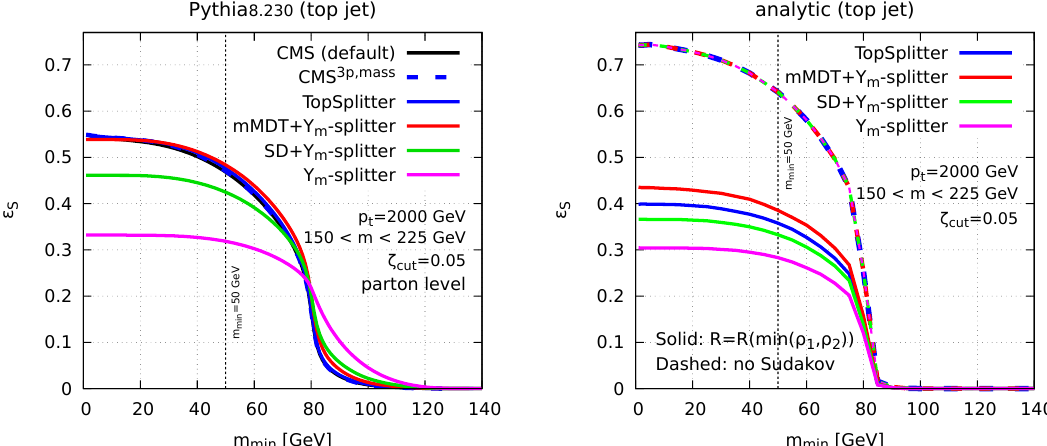
Figure 9. Same as (cid:12)gure 7 this time for signal (top) jets. Also shown is the analytic result without the inclusion of a Sudakov form